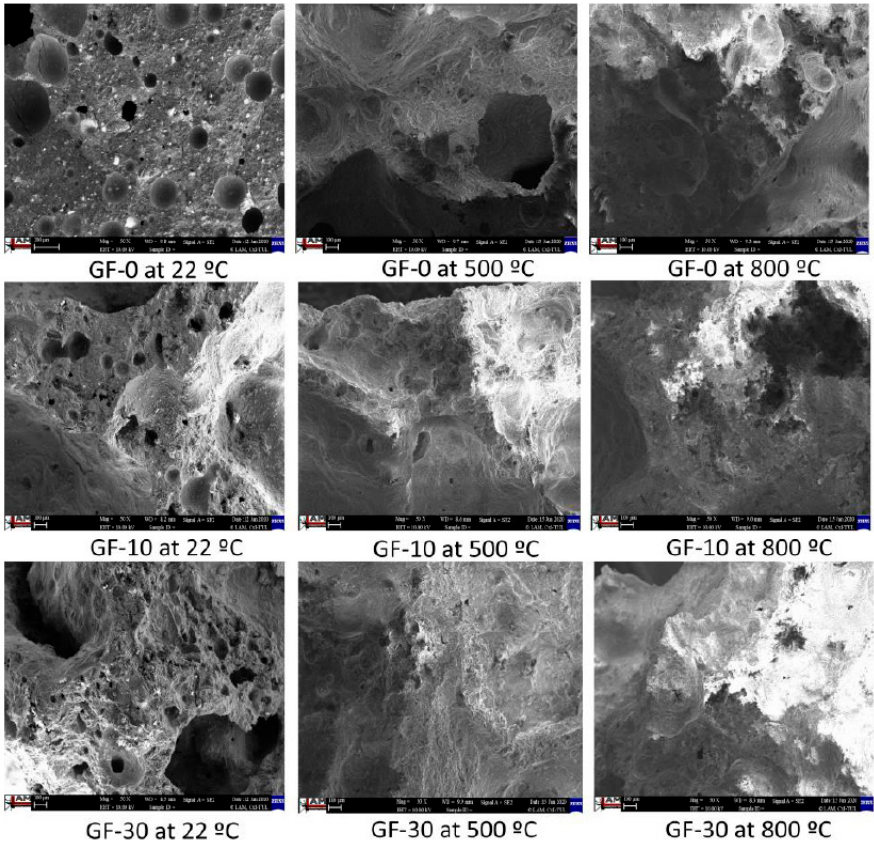
Figure 11. SEM images of the pure foam and composite foams without and with exposure to temperatures of 500 °C and 800 °C.